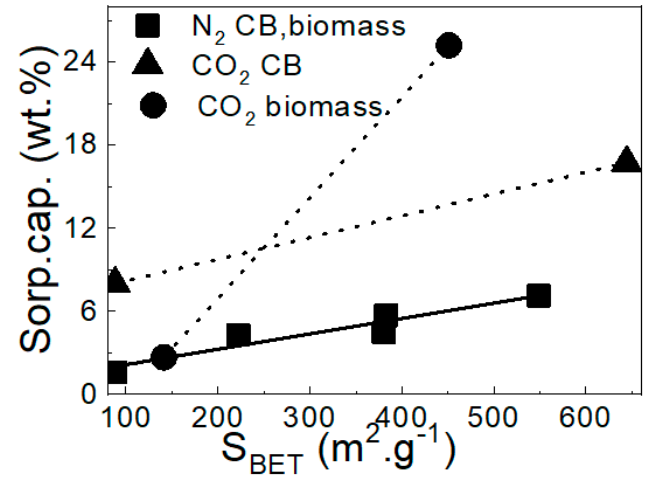
Figure 7. Linear relationship between the specific surface area (S BET ) and sorption capacity of N 2 at the pressure 4000 kPa and of CO 2 at the pressure 2000 kPa for CBa and biomass [16].